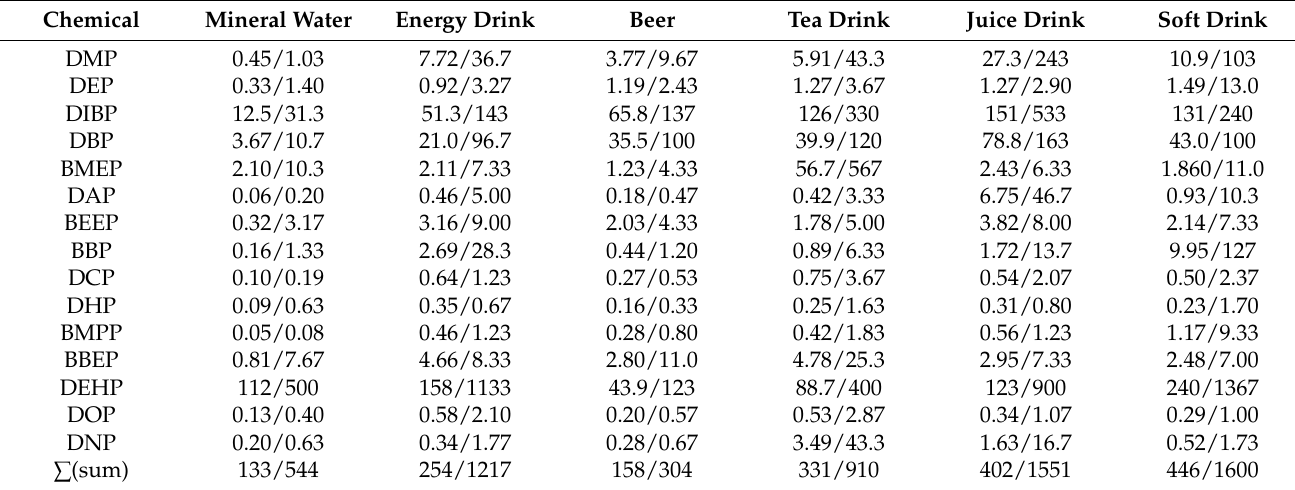
Figure 2. Plots of the canonical analysis of principal (CAP) of PAEs among different types of bottled drinks ( a ) and bottled drinks with different packaging materials ( b ). Permutational multivariate analysis of variance results are also shown in the figure. Table 5. Estimated daily intake (EDI drink , ng/kg-bw/d) of PAEs through ingestion of bottled drinks, based on mean/maximum